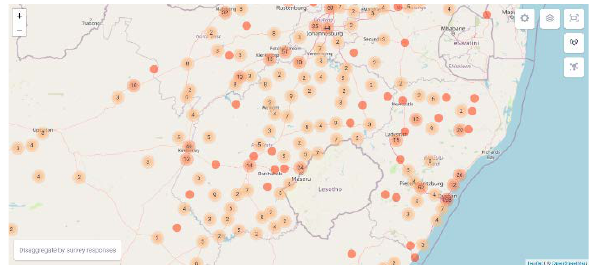
Figure 7: Online map interface showing survey